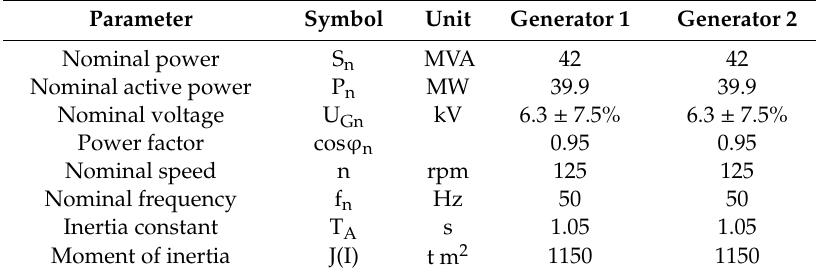
Table 2. Main parameters of generators in the Dubrava